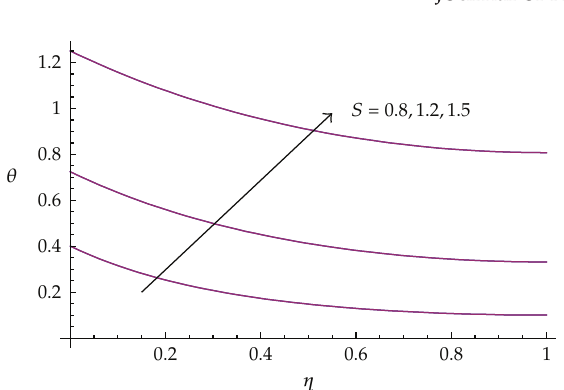
Figure 2: The behavior of the temperature distribution for various values of S with B ∗ (cid:7) 0 . 5, R (cid:7) 0 . 5, and Pr (cid:7) 1.